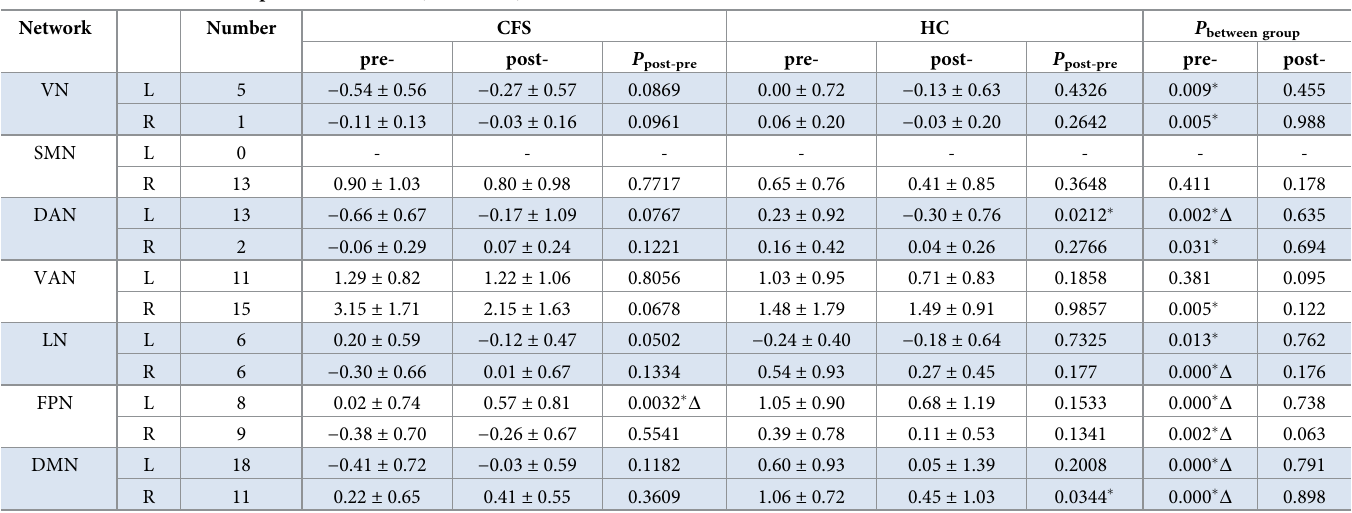
Table 4. Bilateral network comparison of features (mean ± SD).